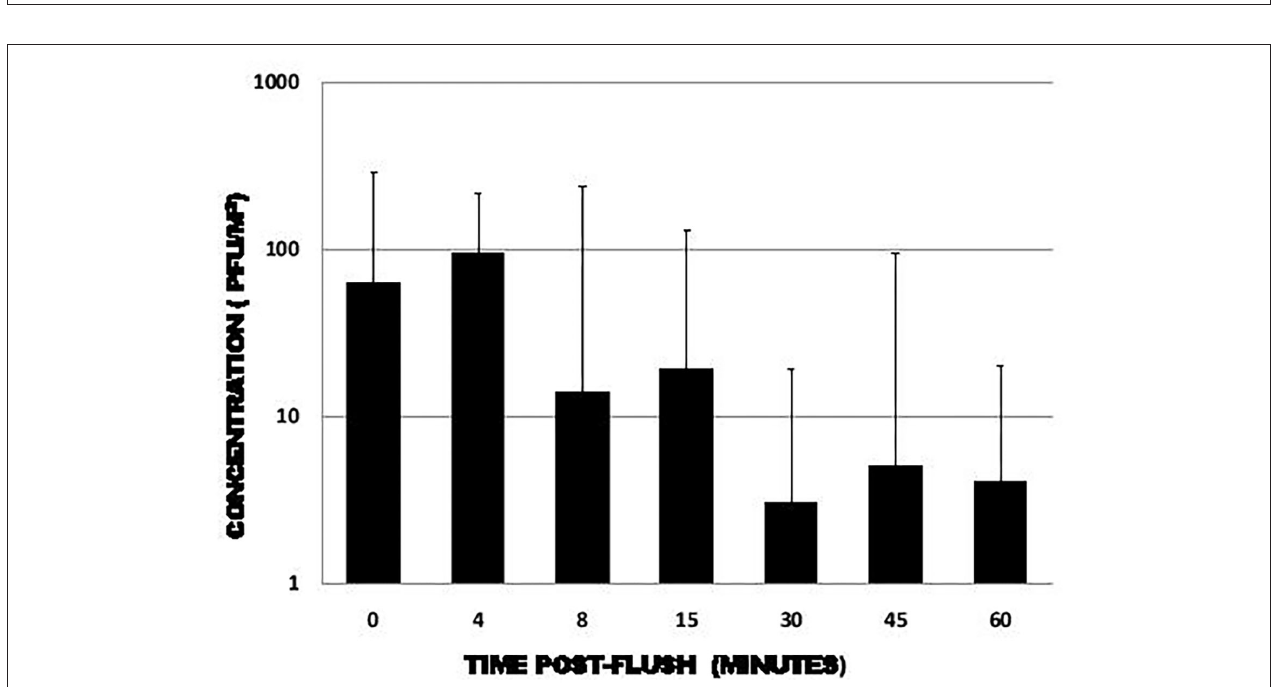
FIGURE 2 | Average concentration of MS2 phases per m 3 as a function of time after one flush (28).